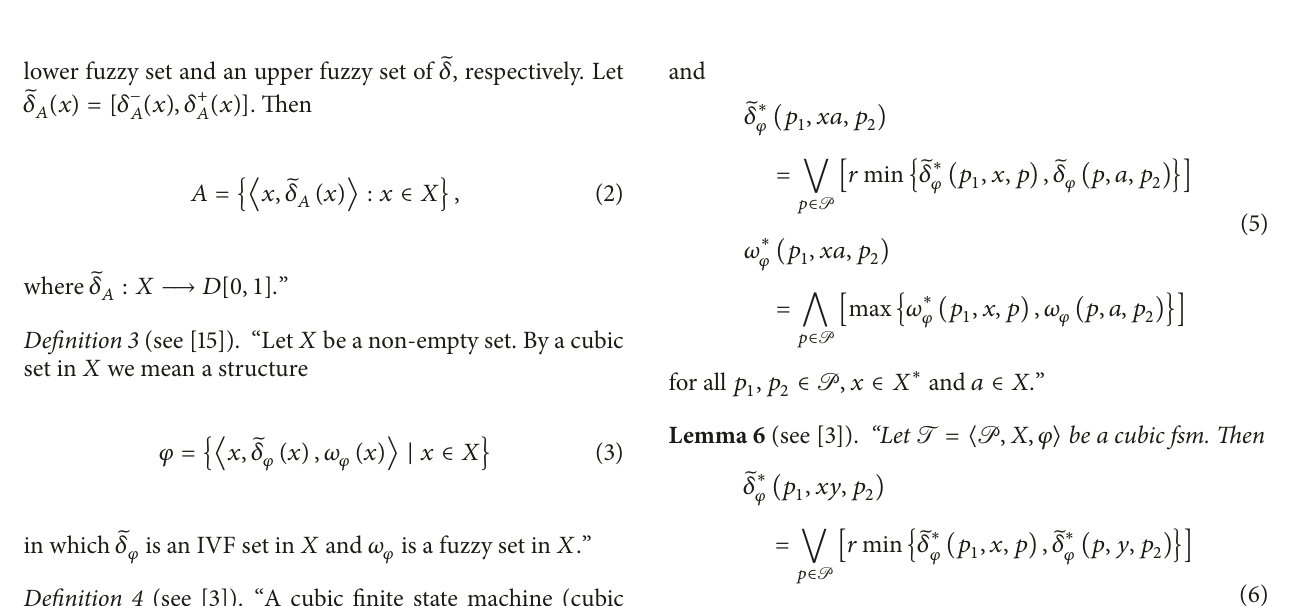
Figure 1: A switching cubic fsm T = ⟨ P , 𝑋,𝜑⟩